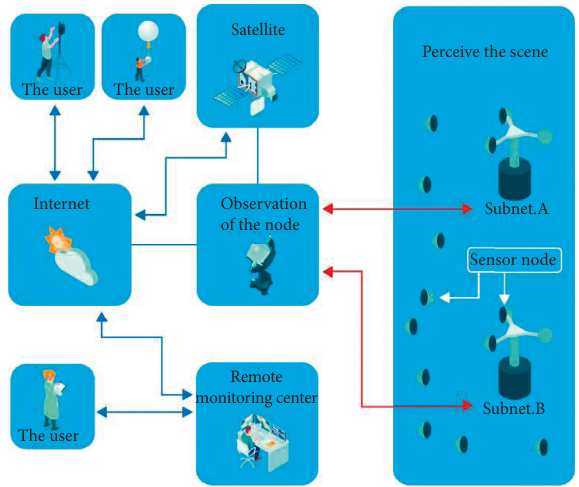
Figure 1: Wireless sensor network